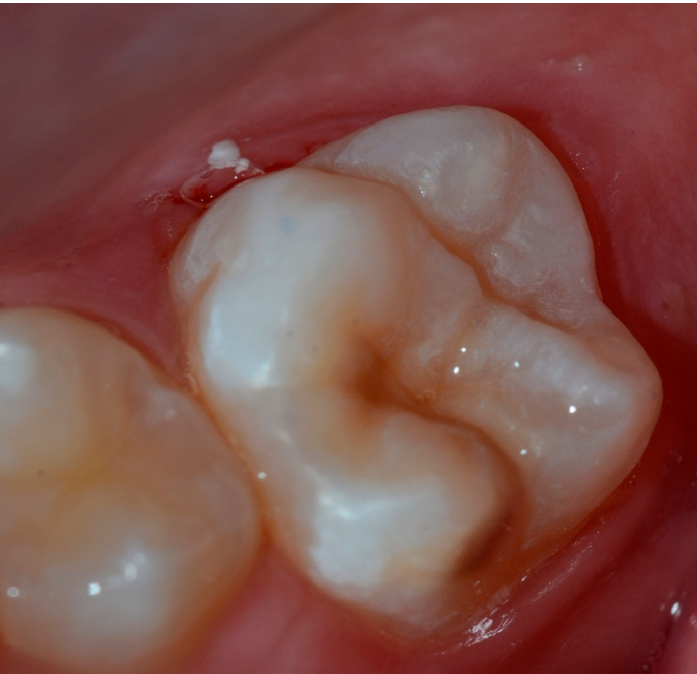
Figure 1. clinical view of enamel defects of permanent molars due to molar incisor Figure 1. Clinical view of enamel defects of permanent molars due to molar incisor hypomineraliza- hypomineralization (MIH). tion